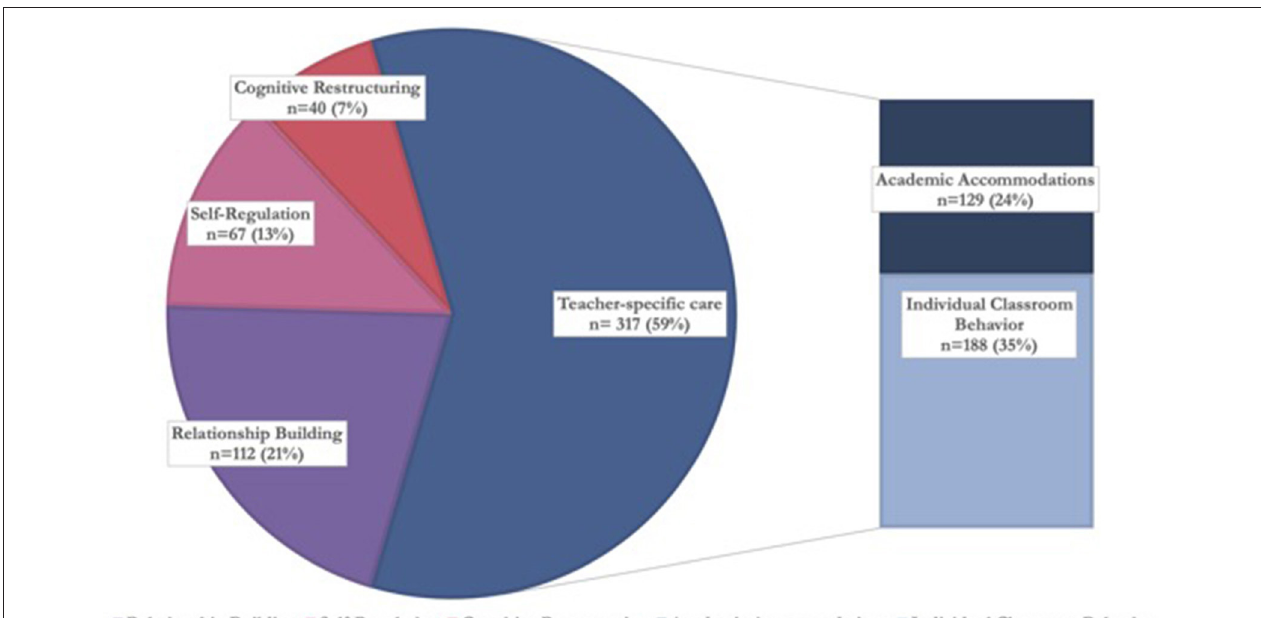
FIGURE 3 | Categories of therapeutic techniques teachers used, grouped by teacher-specific care n =